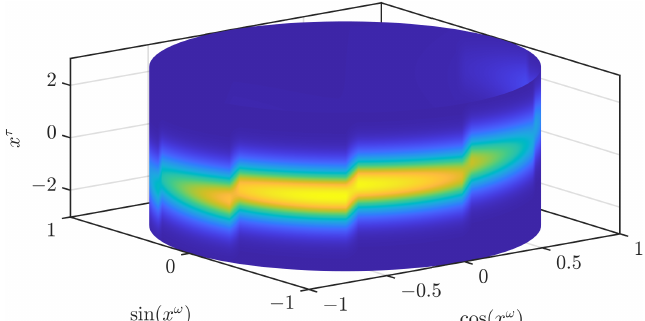
Figure 3. Continuous density based on a trigonometric polynomial for the periodic part.